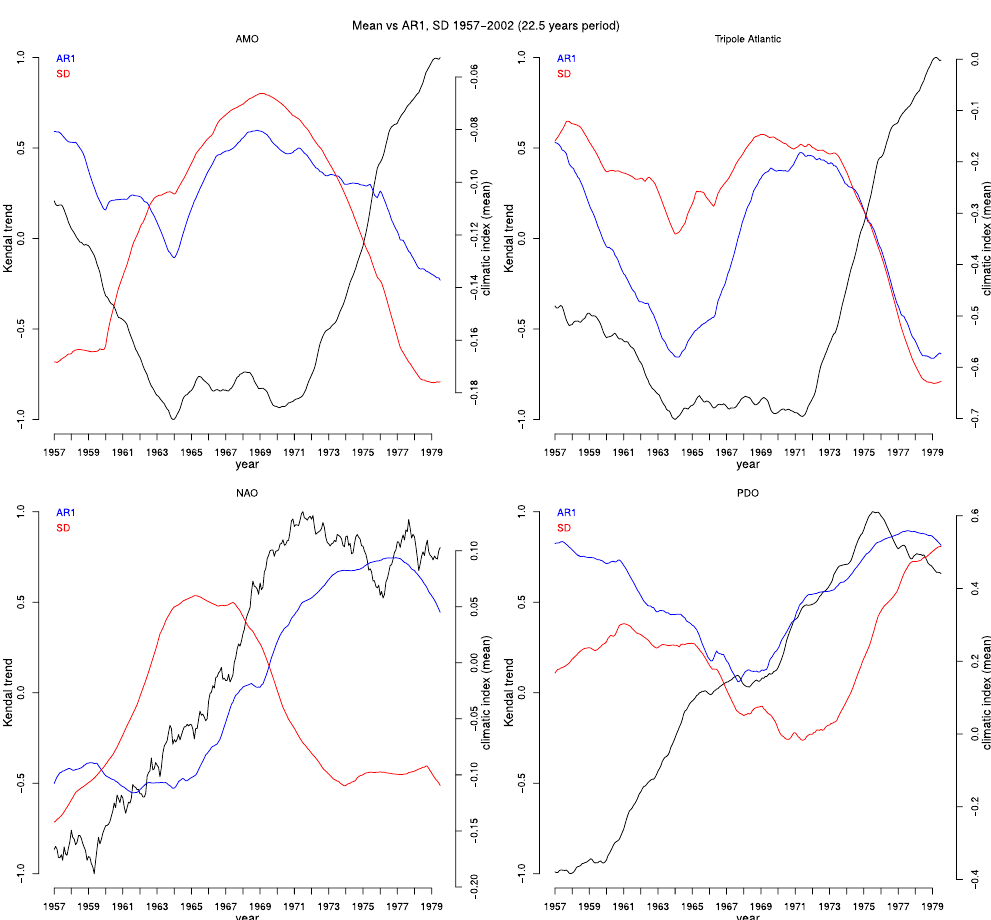
Figure 2. Decadal variability in autocorrelation and variance trends in climate indices. For 22.5 year intervals (within 1957–2002) analysed with filtering bandwidth and sliding window length of half the interval (11 years 3 months). Also plotted is the mean value of the climate index over the same 22.5 year intervals. (top left) AMO, (top right) Atlantic Tripole, (bottom left) NAO, (bottom right)